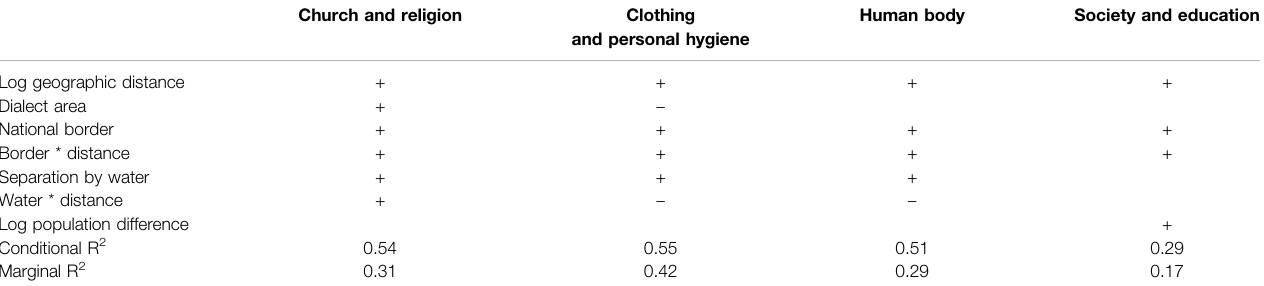
TABLE 15 | Signi fi cant predictors across the four semantic domains (strongest predictor highlighted), and conditional and marginal R 2 -values for the linear mixed-effect models. Church and religion